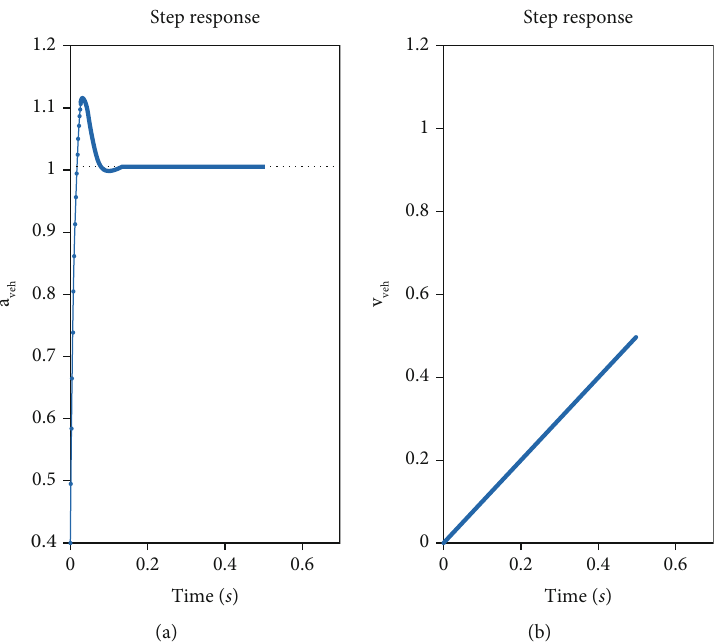
Figure 10: Acceleration (a) and vehicle speed (b), respectively, in closed-loop PID-ZN (3).